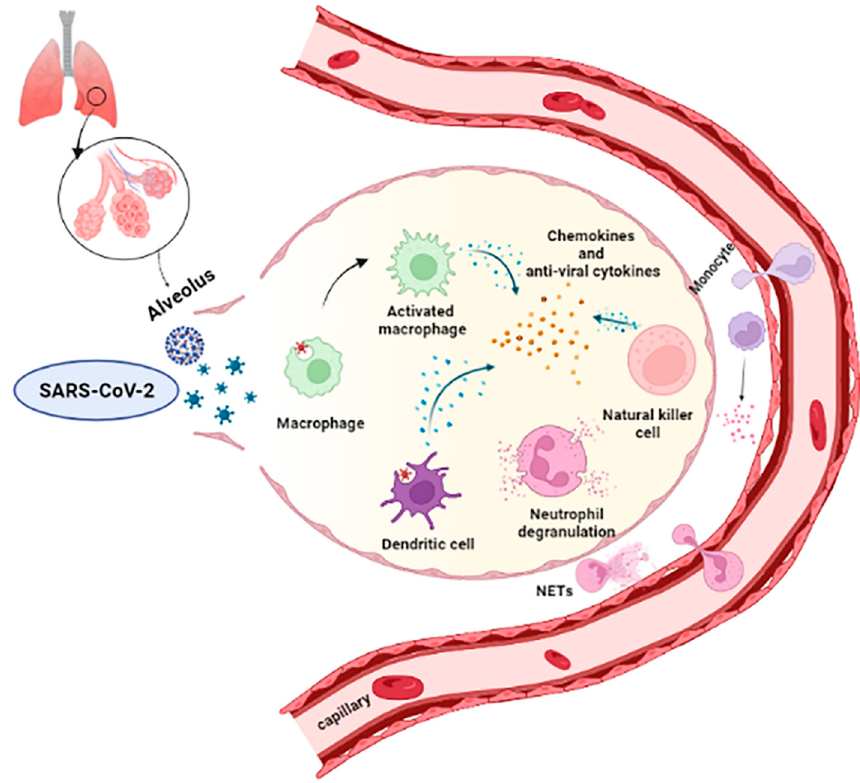
Figure 3. Innate immune response and cytokines storm in SARS-CoV-2 infected lung. The initial viral recognition by tissue-resident immune cells triggers a local innate response. The release of soluble factors, including proinflammatory cytokines and chemokines, from resident immune cells and infected epithelial cells attracts and activates neutrophils, monocytes, macrophages, dendritic cells (DC), natural killers (NK), and innate lymphoid cells into the site of infection, where they contribute to the elimination of the infected cells before virus spreading. This inflammatory environment increased immune cell infiltration from the bloodstream, triggering the “cytokine storm” condition. The hyperinflammation is also sustained by aggregates composed by extracellular DNA fibers, histones, microbicidal proteins, and proteases released from the recruited neutrophils, named also extracellular traps (NETs).